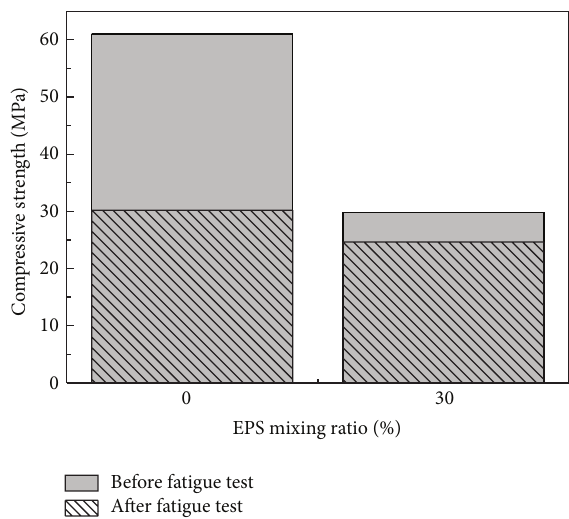
Figure 12: Later strength of 50 KN 100000-time cyclic loading.